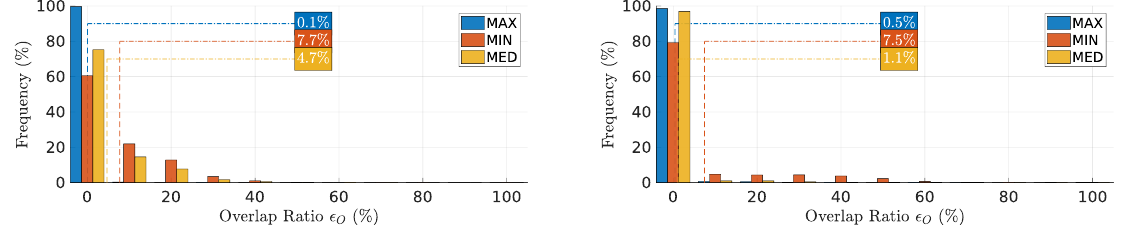
Figure 9. Overlap ratio (cid:101) O on the first and second relays, left and right, respectively. MAX exhibits almost no overlapping packets.